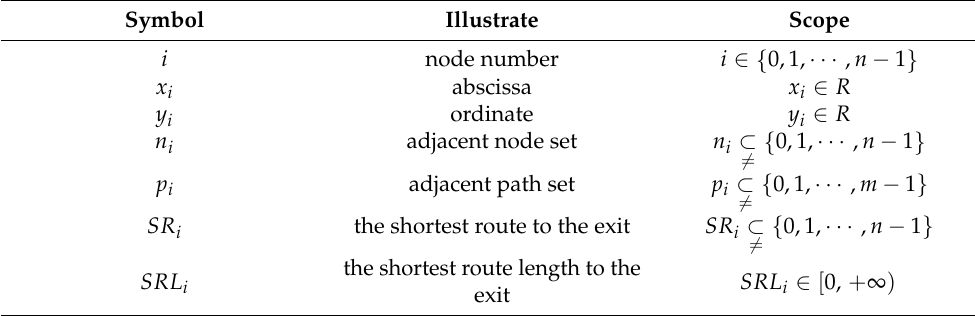
Table 1. Attribute description and scope of the node.